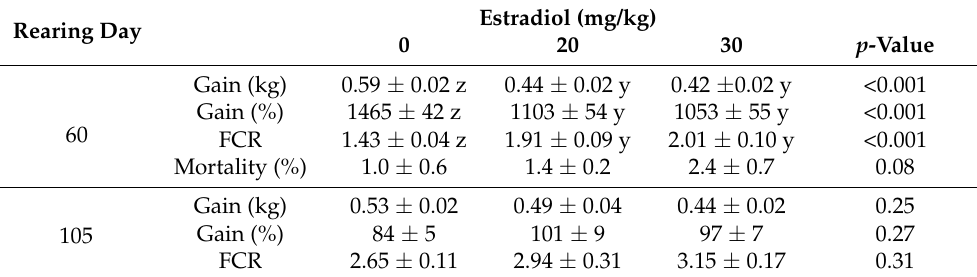
Table 1. Mean (± SE) total weight gain, percent weight gain, feed conversion ratio (FCR a ), and mortality for brown trout Salmo trutta fed three different concentrations of estradiol/kg of feed for 60 days starting at initial feeding. Means with different letters in the same row differ significantly ( p < 0.05, n = 4).